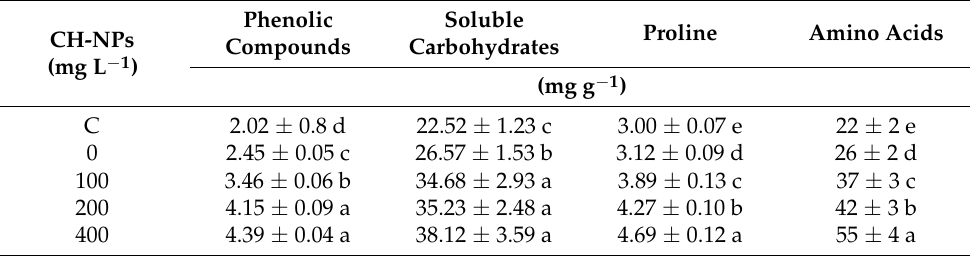
Table 2. Effect of chitosan nanoparticles (CH-NPs) on some biochemical traits in the leaves of banana plants exposed to cold stress (5 ◦ C for 72